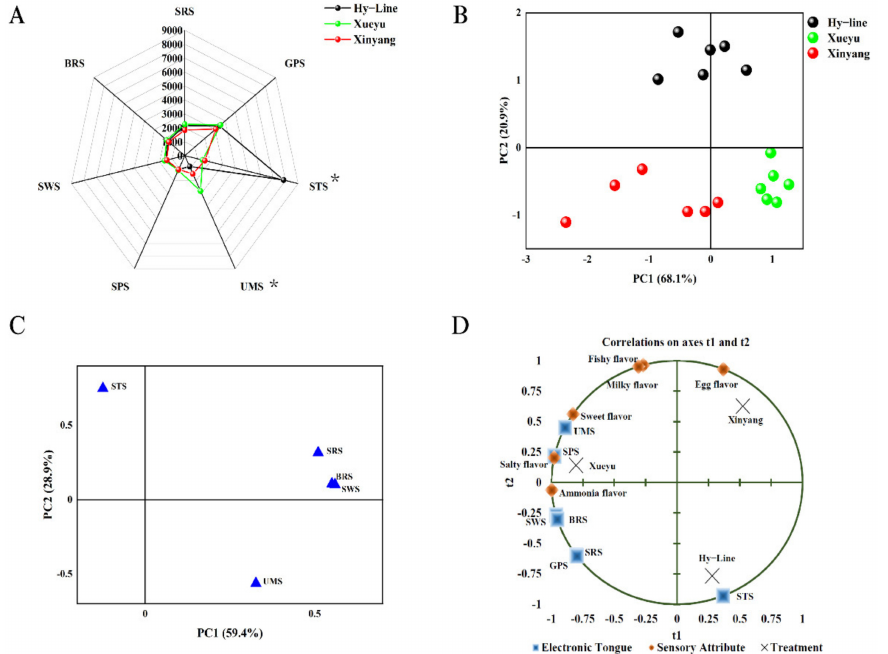
Figure 2. Presents the results of E-tongue sensors on flavor of boiled egg yolk from Hy-Line, Xueyu, and Xinyang laying hens; Radar chart of the E- tongue response data ( A ), score plot ( B ) of egg yolks, PCA loading plot ( C ) of the E- tongue response data and an overview of the correlation loadings ( D ) from PLS analyses with flavor compounds detected by the E- tongue as X-variables and sensory attributes as Y-variables. Note: * Means significant difference ( p < 0.05). Hy-Line: Hy-Line brown;